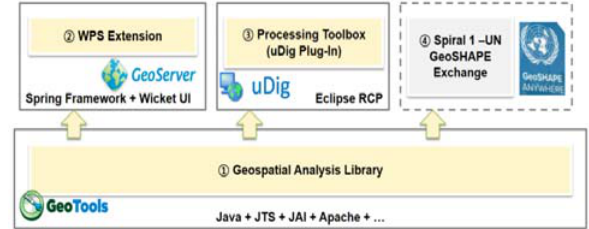
Figure 1. Key components of Spiral 3 development